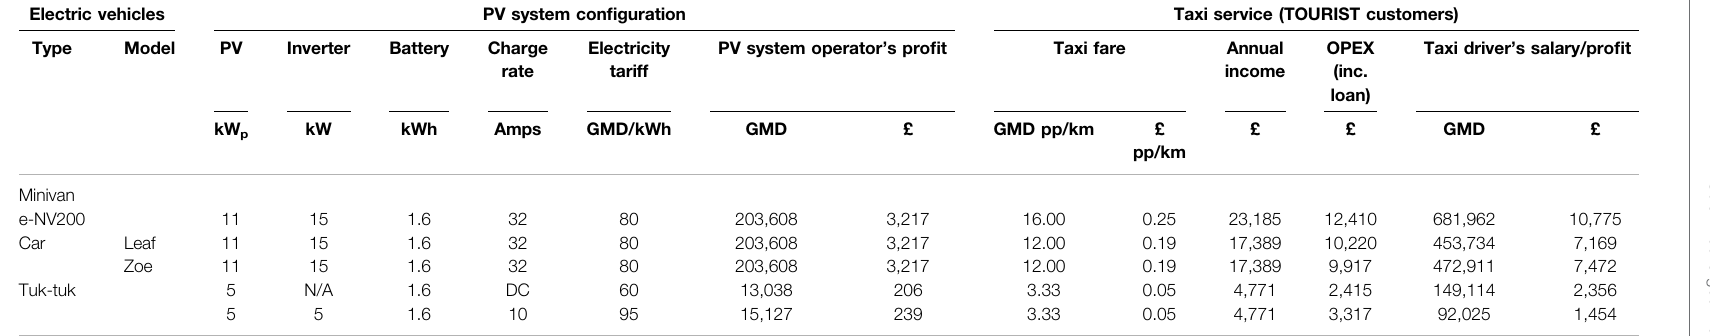
TABLE 4 | EV con fi gurations that are commercially viable for